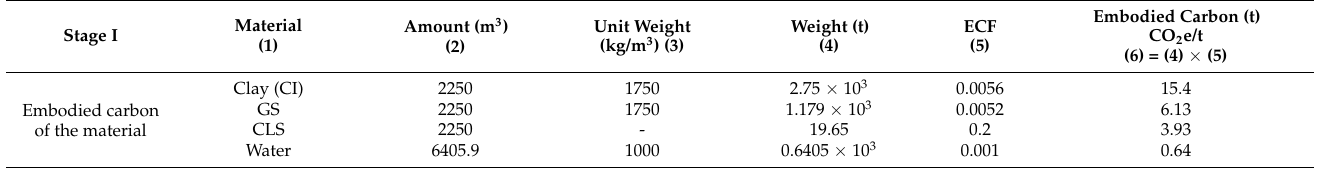
Table 4. Evaluation of carbon emissions from materials.